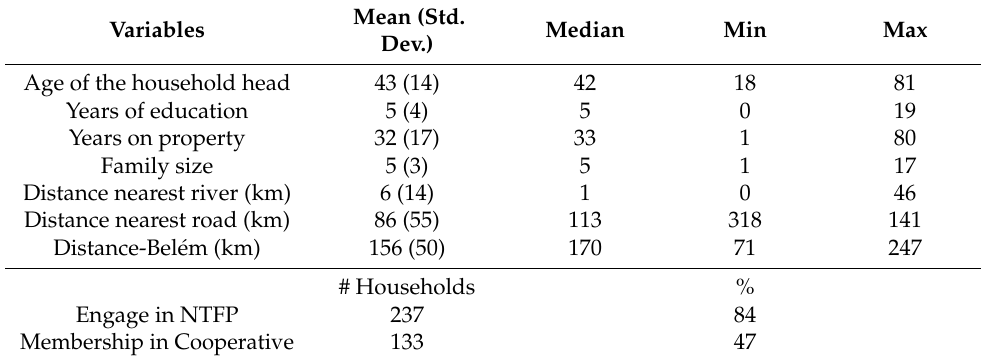
Table 2. General characteristics of the households ( n =